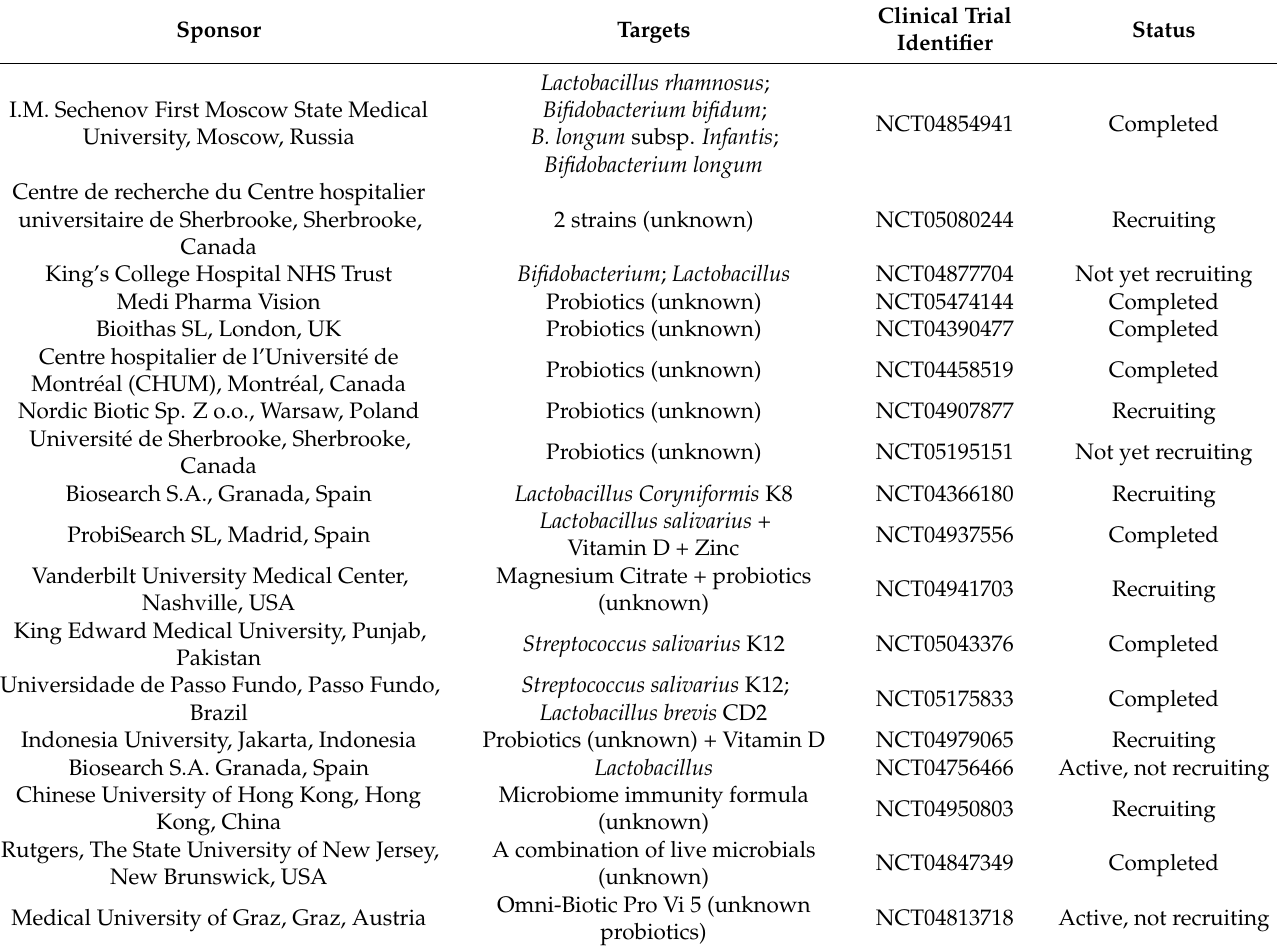
Table 1. Current probiotics clinical trials related to gut injury of COVID-19